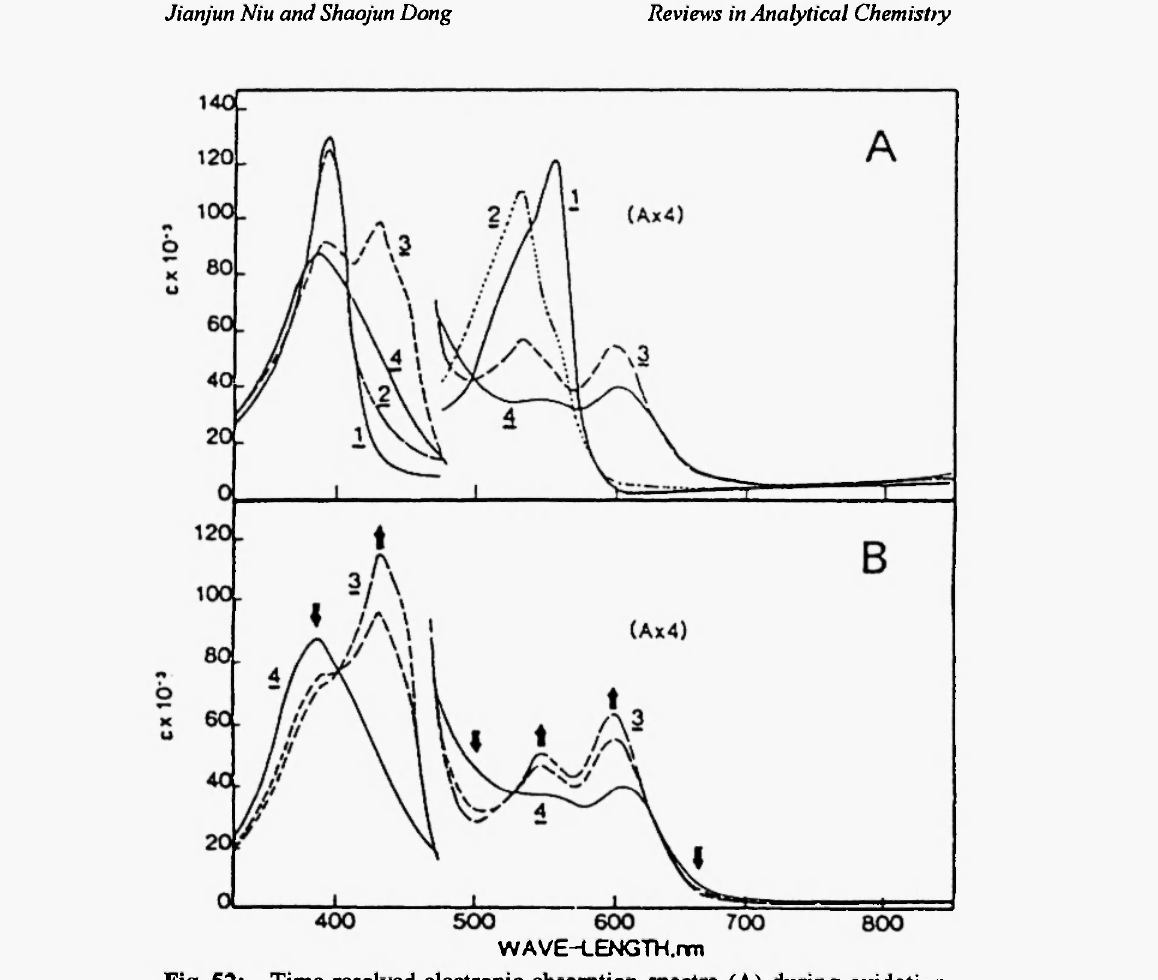
Fig. 52: Time-resolved electronic absorption spectra (A) during oxidation of (OEP)Fe(C6H ) at +0.80 V, carried out at a thin-layer gold 5 electrode in PhCN, 0.3 Μ TBA(PF ). Time of electrolysis: 0.0 s 6 (1), 10 s (2), 60 s (3), and 420 s (4). (B) During reduction of [( V-C H OEP)Fe m ] 2+ , 4, at -0.40 V, in PhCN, 0.3 Μ TBA(PF i 6 5 Time of electrolysis: 0.0, 40, and 60 s. (From Ref. 322)